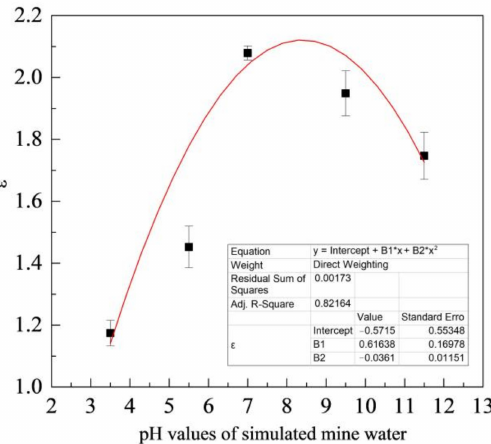
Figure 9. Change of relative wear-resisting coefficient with pH values of simulated mine